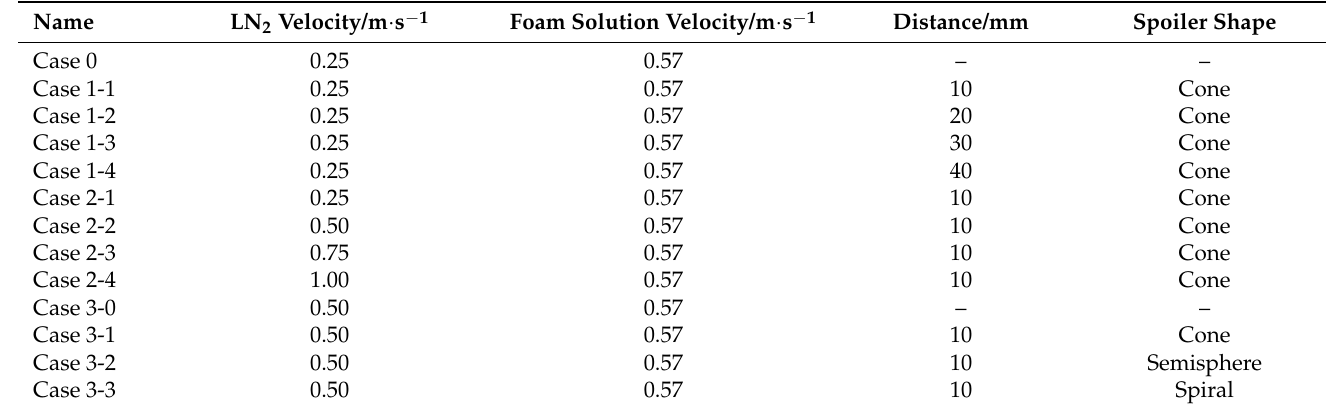
Table 3. The working conditions for all